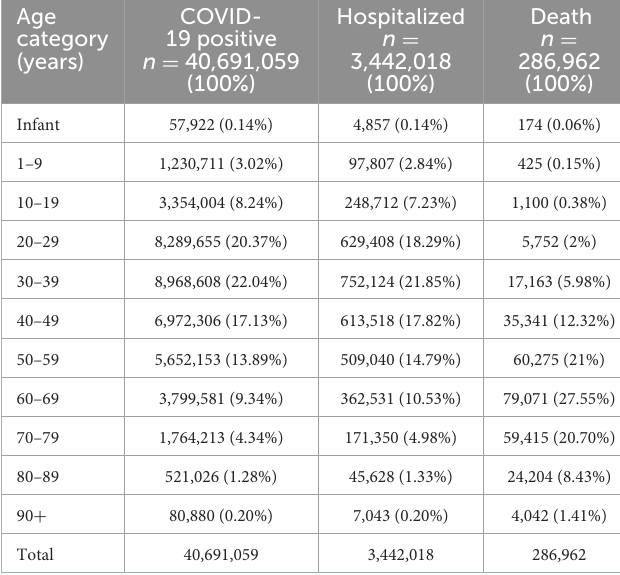
TABLE 1 Characteristics of patients with COVID-19 in diverse age